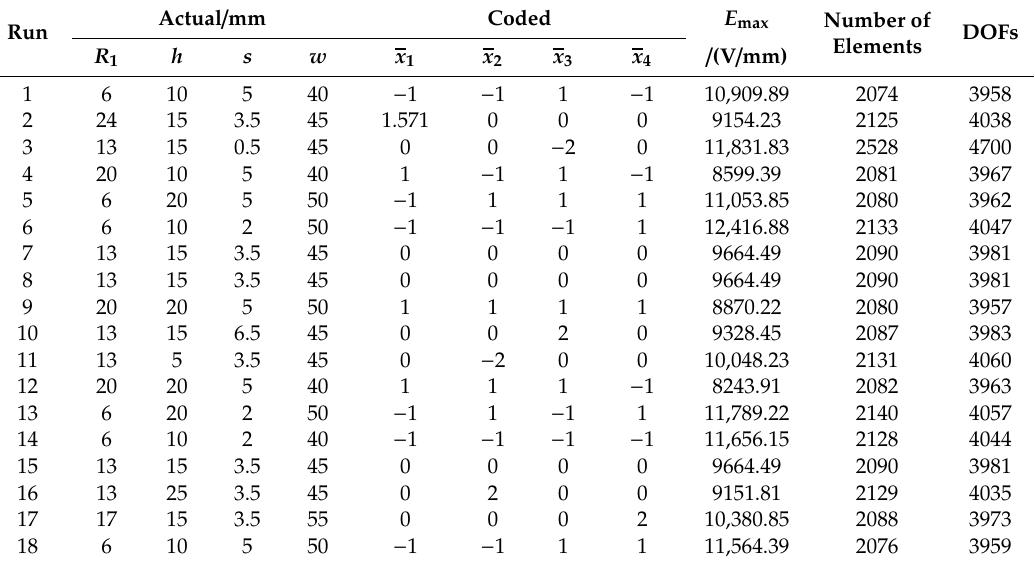
Table 6. Experimental